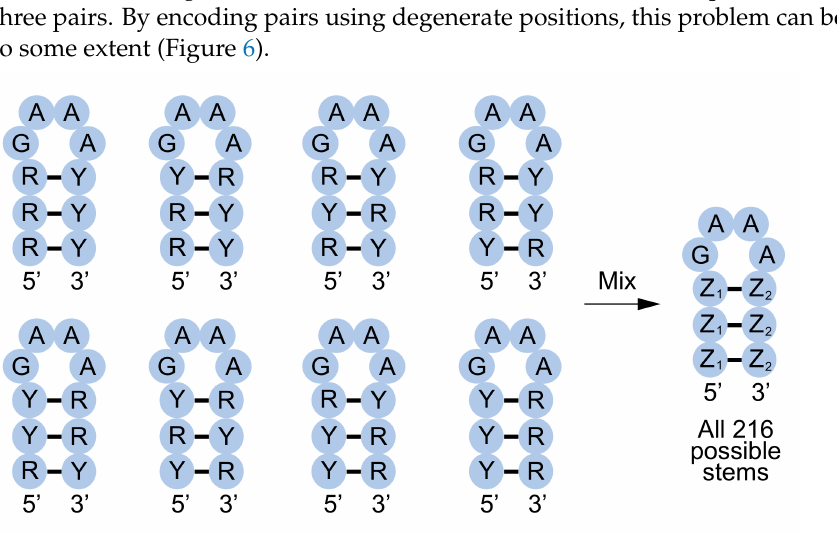
Figure 6. Synthesis of secondary structure libraries using a split-and-pool approach. In this example, a library containing all possible variants of a stem is constructed by synthesizing eight different oligonucleotides in which base pairs are encoded by different combinations of R-Y and Y-R. These oligonucleotides are mixed to generate the final library containing 512 different sequences, including each of the 216 possible stem sequences. Z 1 -Z 2 = R-Y or